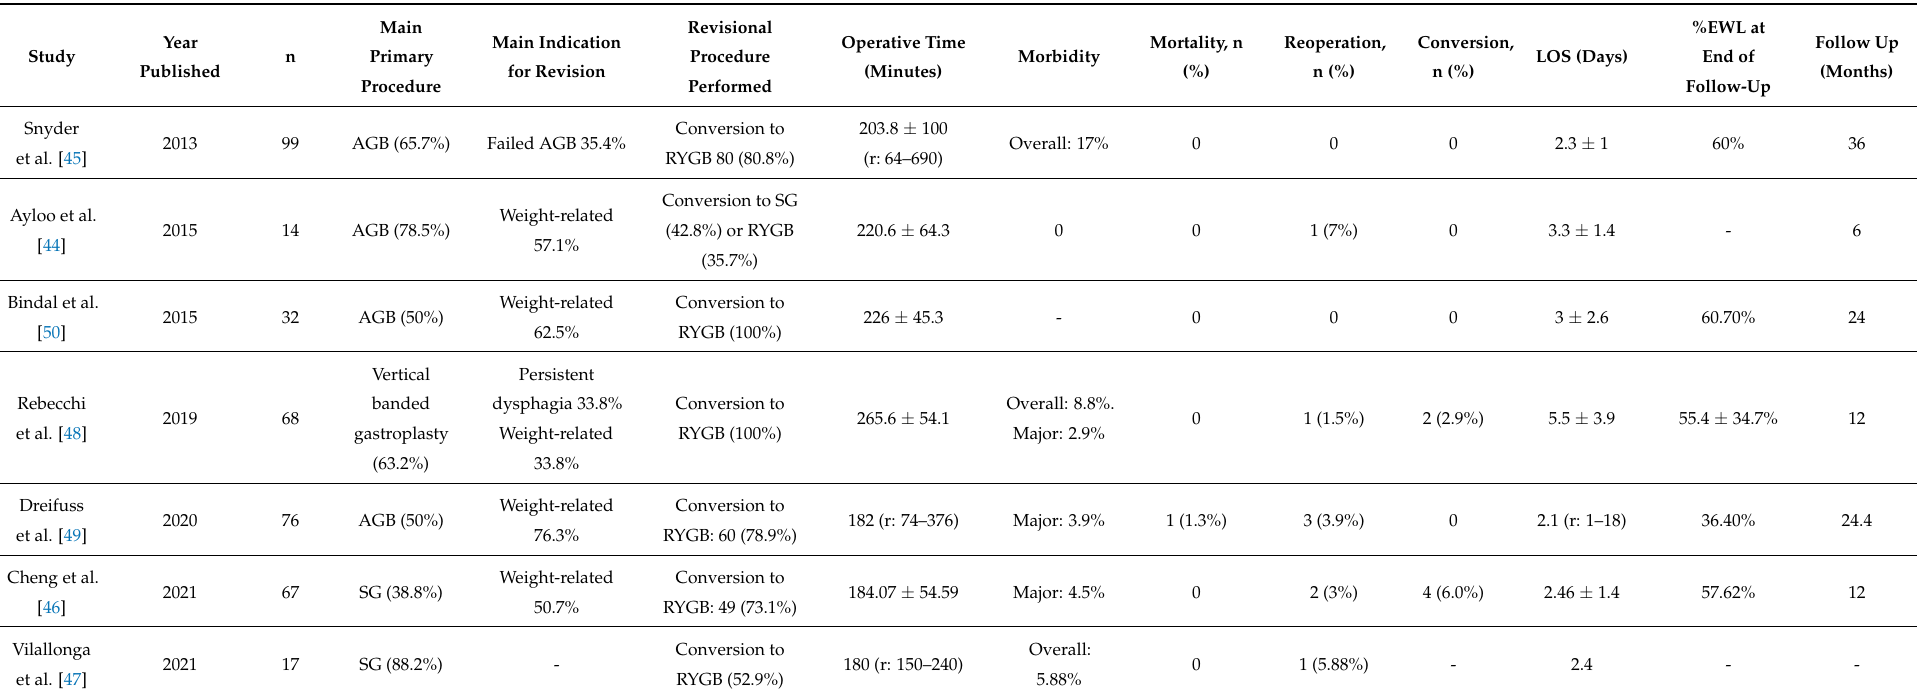
Table 2. Outcomes of robot-assisted revisional bariatric